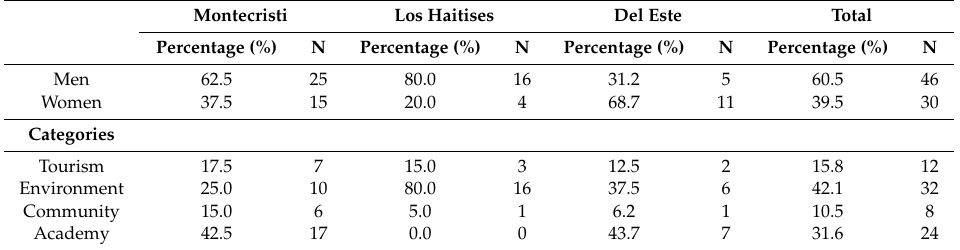
Table 4. Number (N) and percentage of participants of the national parks